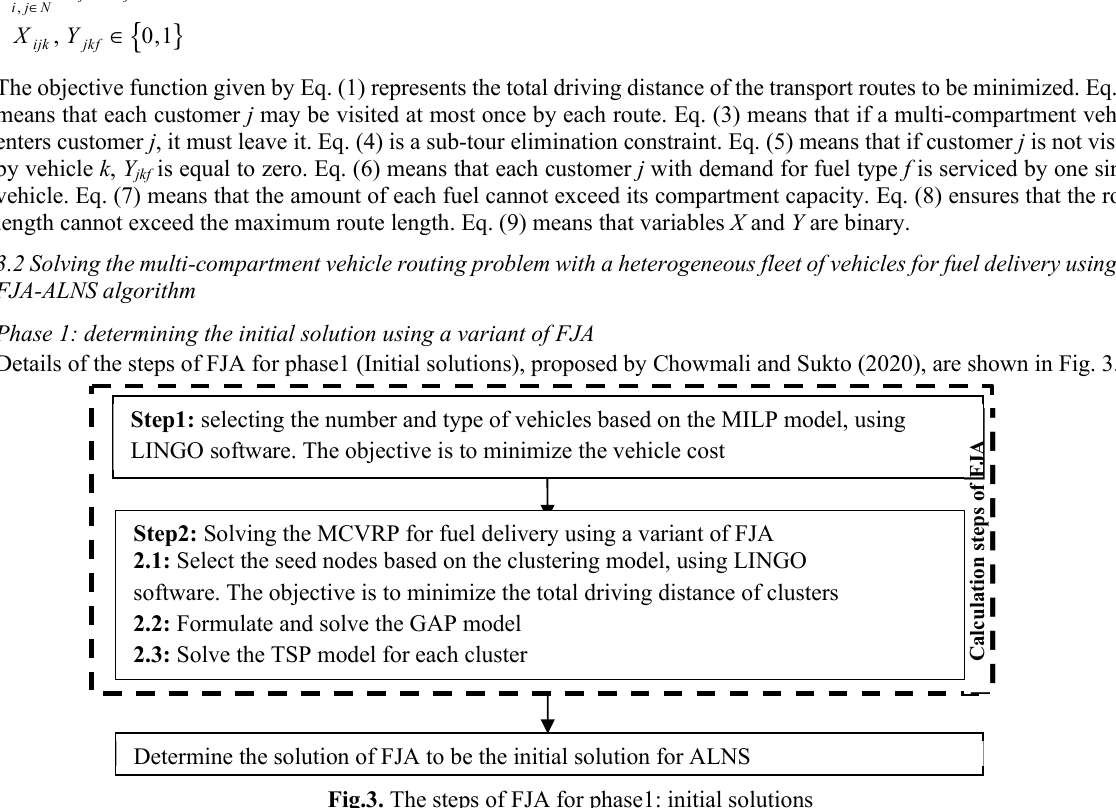
Fig.3. The steps of FJA for phase1: initial